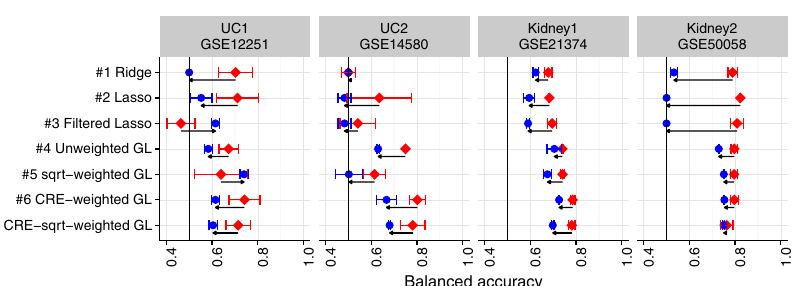
Figure 4. Overview of model performance in nested cross-validation (red diamonds) and independent test sets (blue squares). Each row depicts performance in one of the methods outlined in Table 1. The x-axis corresponds to the average achieved balanced accuracy in multiple runs using the best λ value in each run. The horizontal error bars correspond to one standard deviation. Arrows indicate the magnitude of the change between cross- validation and independent tests. Note that in almost all cases performance deteriorates in the independent setting and that prior-knowledge based methods are better able to retain high predictive